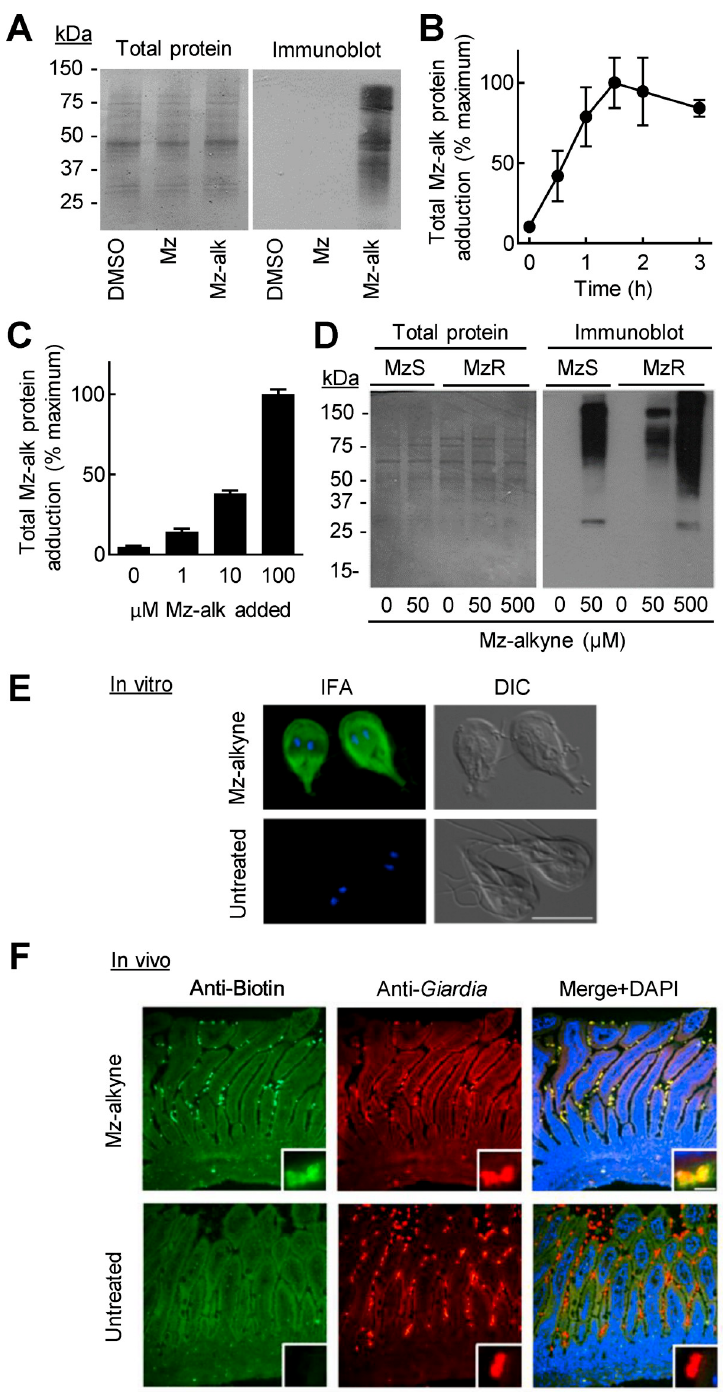
Fig 3. Biochemical detection of 5-NI drug adduction in G . lamblia . A. Trophozoites of G . lamblia WB were treated for 2 h with Mz-alkyne (Mz-alk) or Mz (both at ~30 x of their respective EC50), or with DMSO as a solvent control. After gel electrophoresis of cell extracts, adducted proteins were analyzed by immunoblotting using in situ click chemistry for coupling with azido-biotin followed by staining with HRP-labeled anti-biotin and visualization by chemiluminescence. Total protein was stained with Coomassie Blue. B,C. Trophozoites were treated with 100 μ M (B) or the indicated concentrations (C) of Mz-alkyne for the indicated periods (B) or 2 h (C). Cells were washed and lysed, and the extracts were reacted with azido-biotin by the click reaction and coated onto 96-well plates. Bound biotin- labeled proteins were detected with streptavidin-HRP followed by incubation with the substrates TMB and H 2 O 2 .